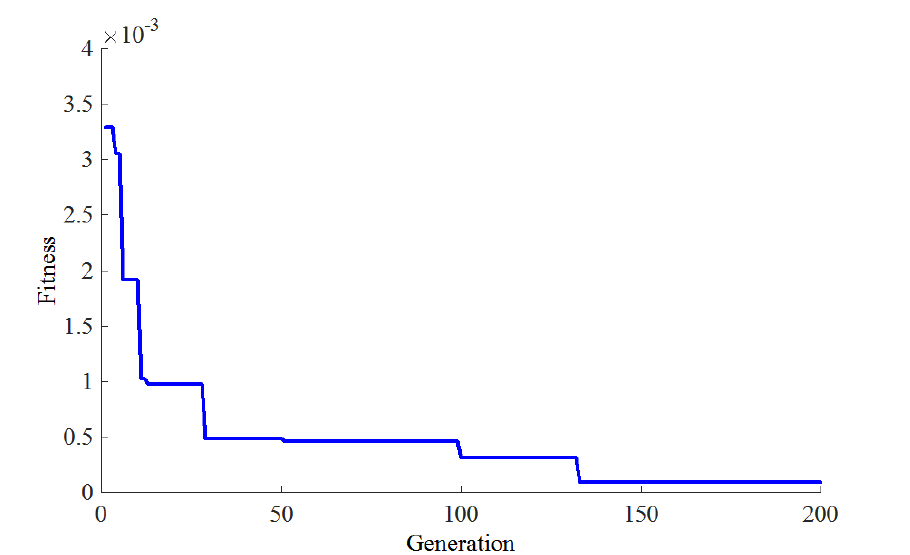
Fig. 4 Variation of fitness index with generation for the clamped-free